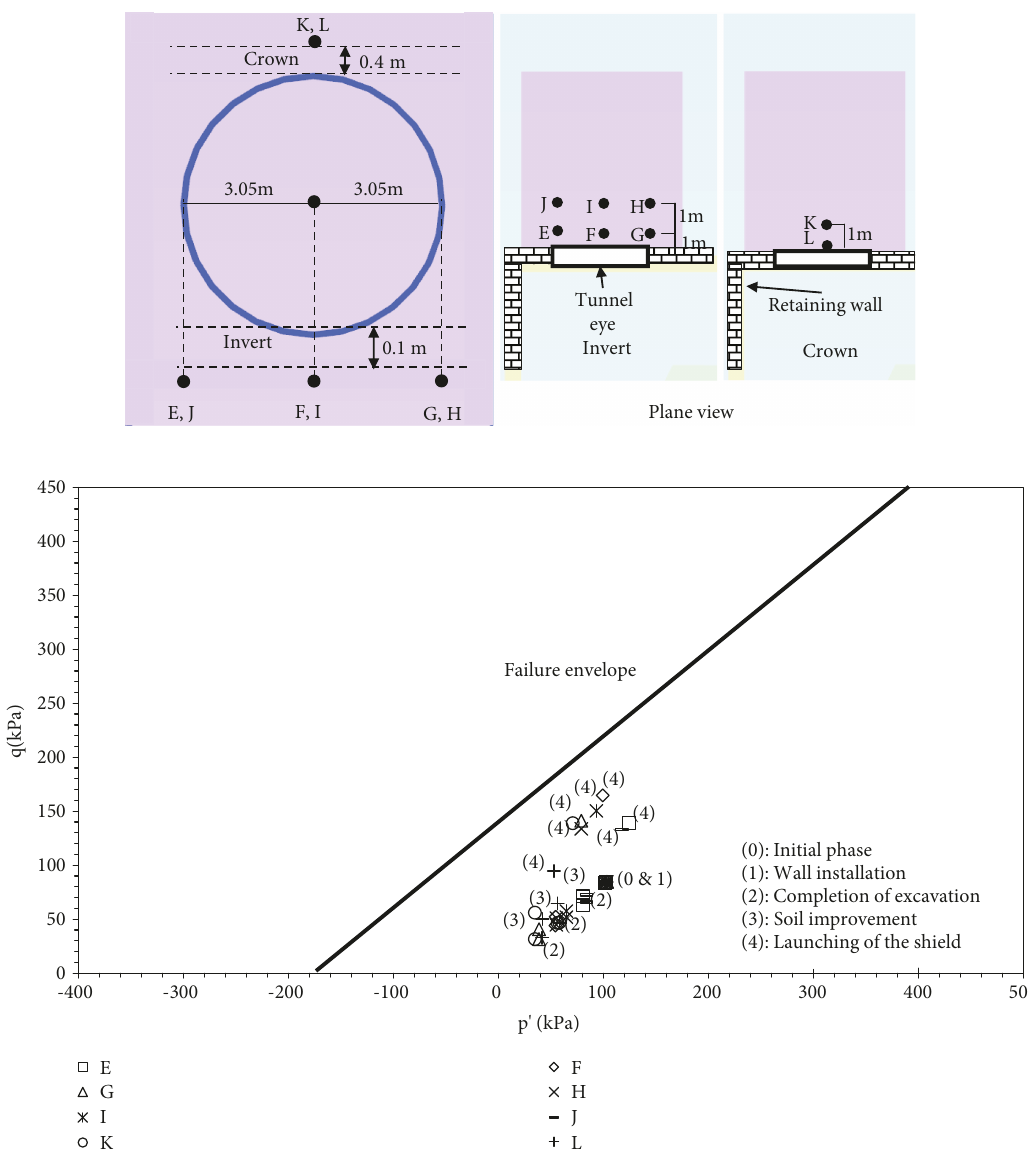
Figure 11: E ff ective stress path and failure mechanism for soils at various locations outside the